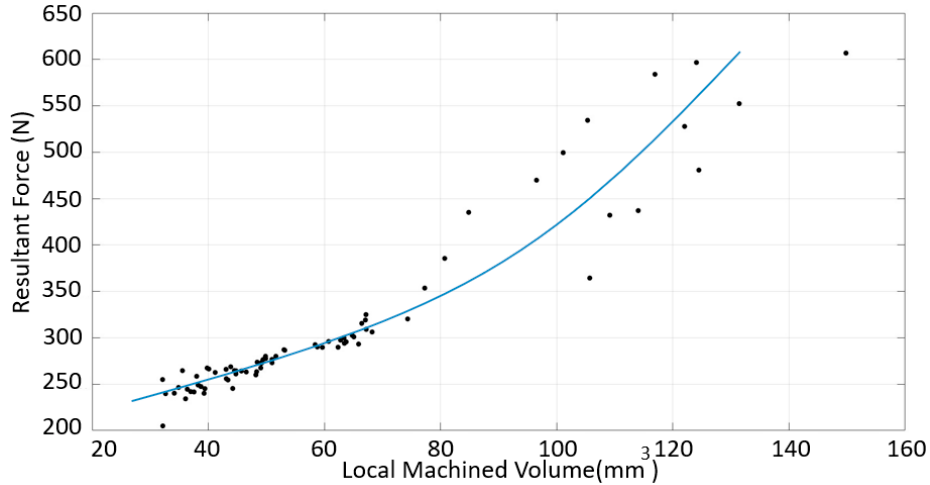
Figure 15. Resultant force vs. volume for the SS material, down ‐ milling cases.